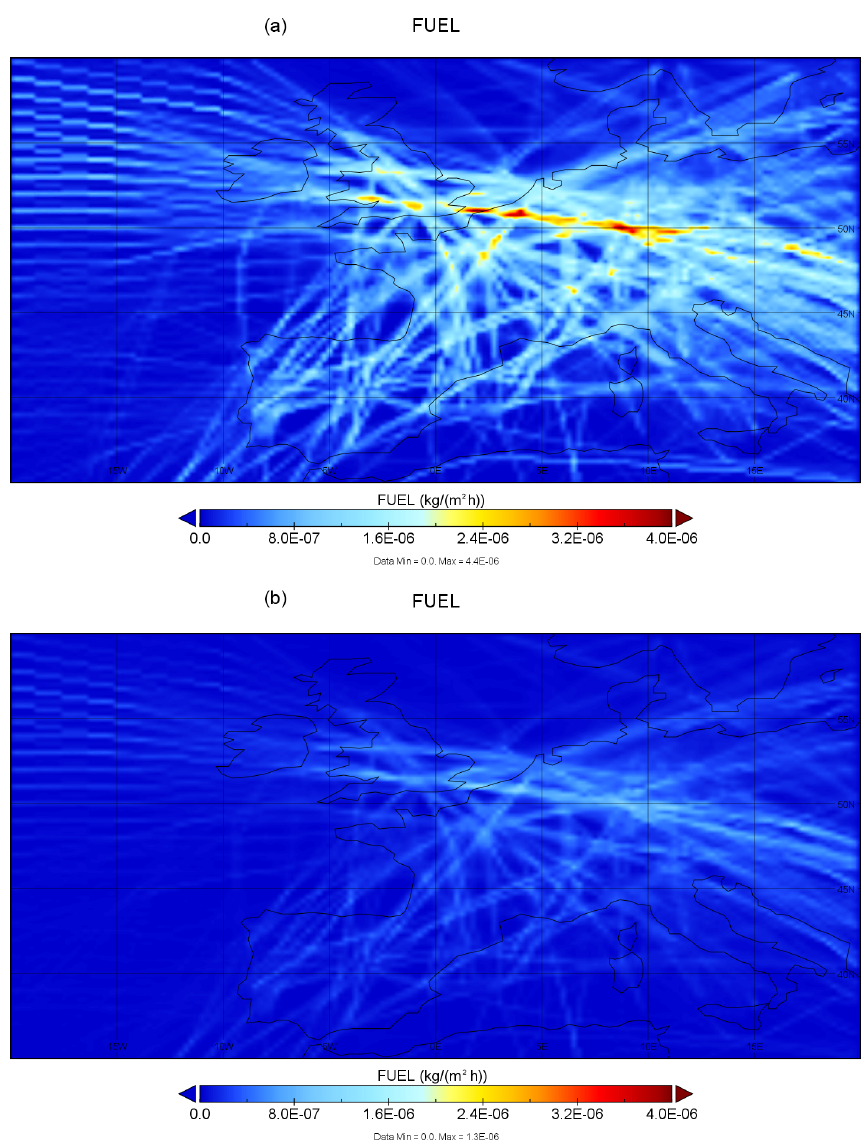
Figure 3. Mean fuel consumption (in kgm − 2 h − 1 ) over the European domain from March–August in 2019 (a) and 2020 (b)